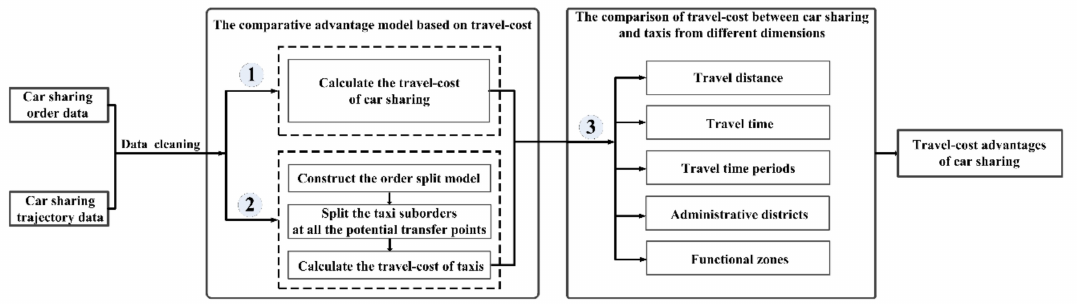
Figure 3. Methodology of the study.